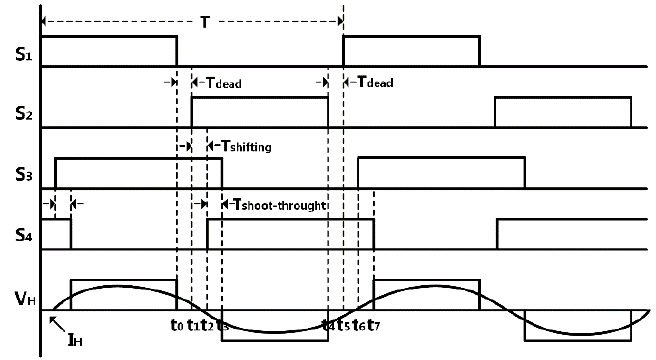
Figure 9. q ‐ Zsource based voltage boost control sequences. Figure 9. q-Zsource based voltage boost control sequences.